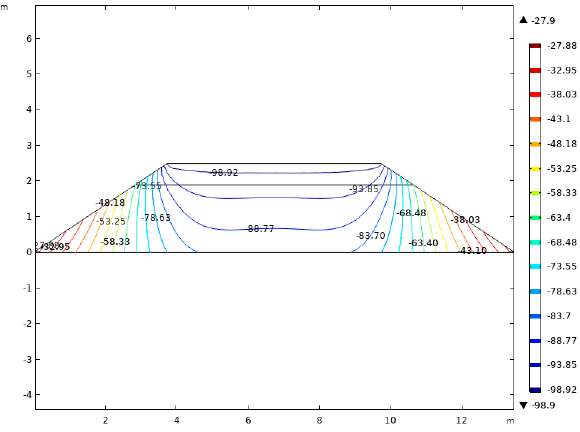
Figure 18. Contours of vertical effective stress at the steady state (time is 11,000 min) of fluid flow (unit: kPa).